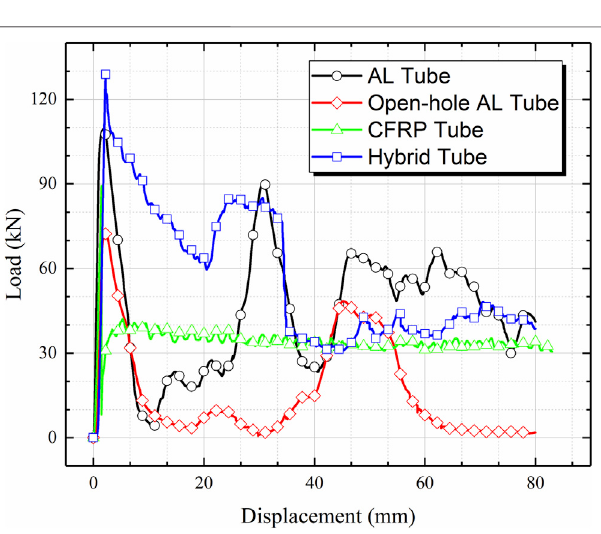
FIGURE 7 | Load – displacement curve of four investigated